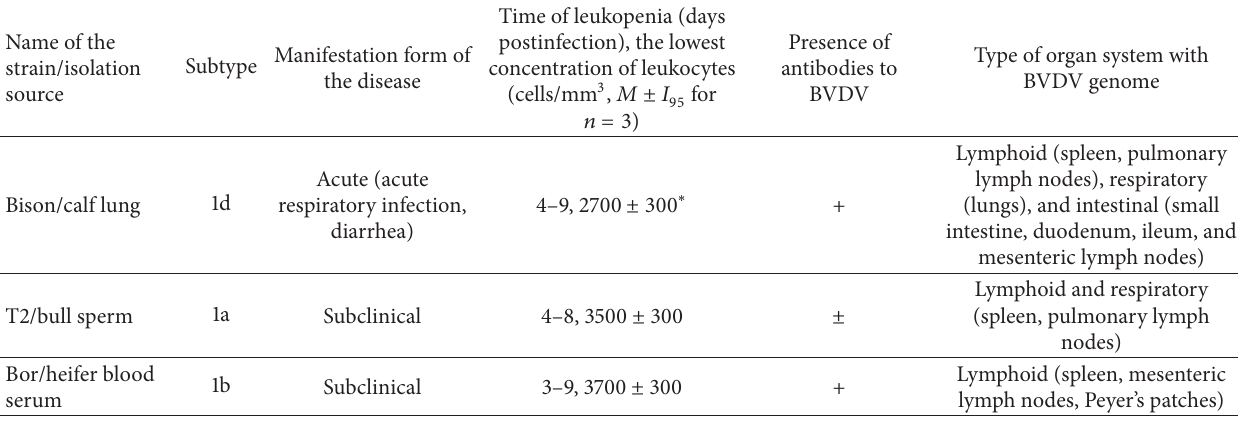
Table 1: Pathogenic propertiesof bovine viral diarrhea virus(BVDV) noncytopathic strainsof type1 after aerosol challenge of 4–6-month-old calves with the dose of 6 log 10 TCD 50